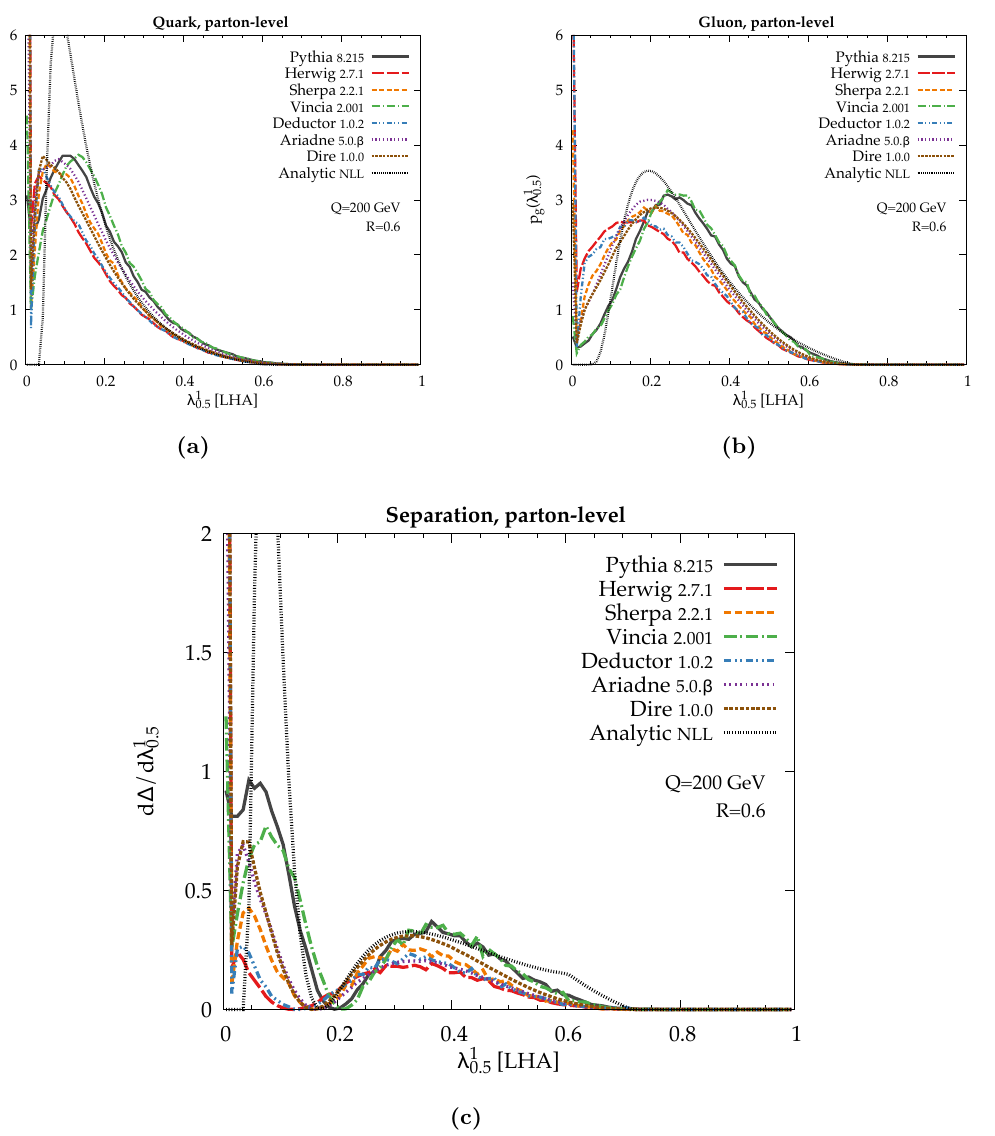
Figure 6. Same as (cid:12)gure 5, but at the parton level. Note that Herwig , Sherpa , and Deductor all have cross section spikes at (cid:21) 1 = 0 that extend above the plotted 0 : 5